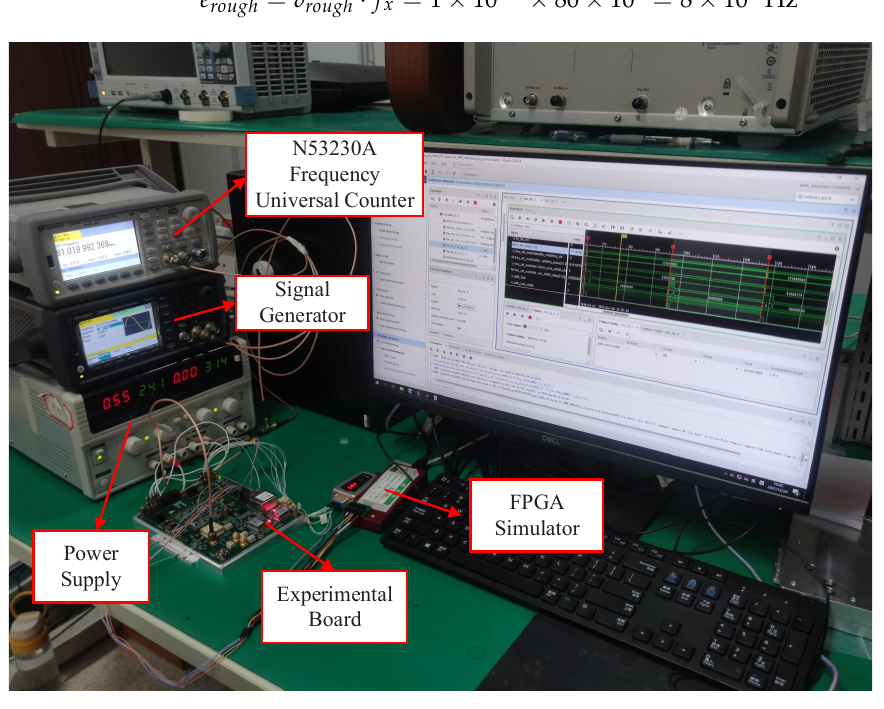
Figure 13. Photograph of conducting testing